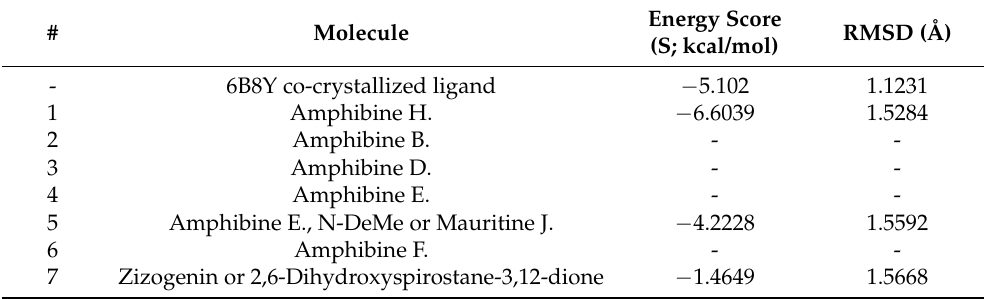
Table 4. Interaction binding energy (kcal/mol) and binding accuracy (RMSD; Å) of ZFE-derived compounds and the co-crystallized ligand within TGFBR1 kinase (PDB ID: 6B8Y; 1.65